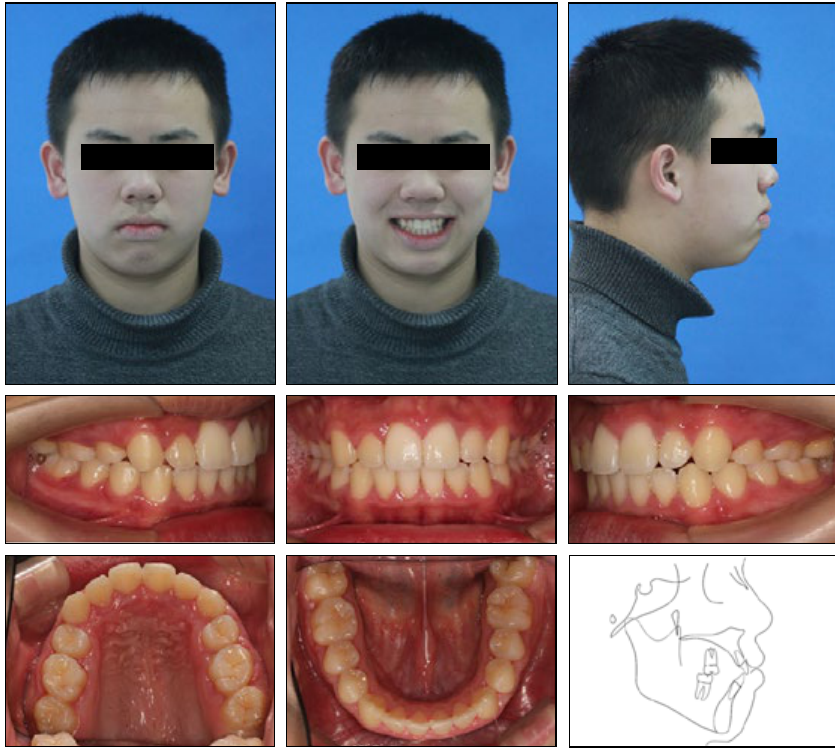
Figure 7. Phase two post-treatment photographs and cephalometric tracing.